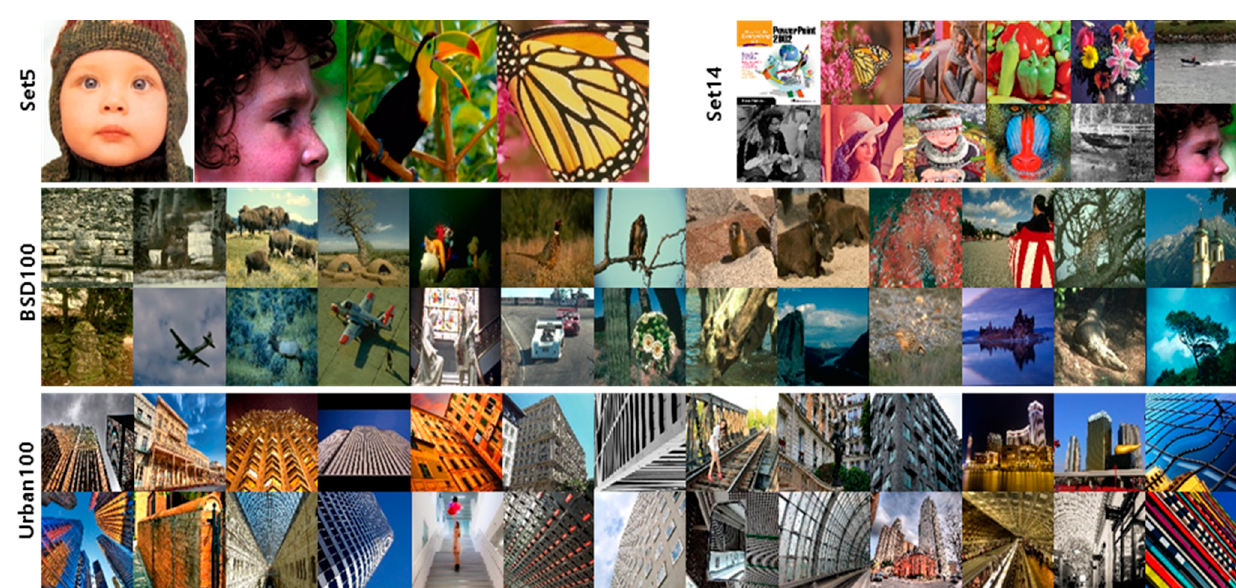
Figure 5. Training dataset (DIV2K [37]).